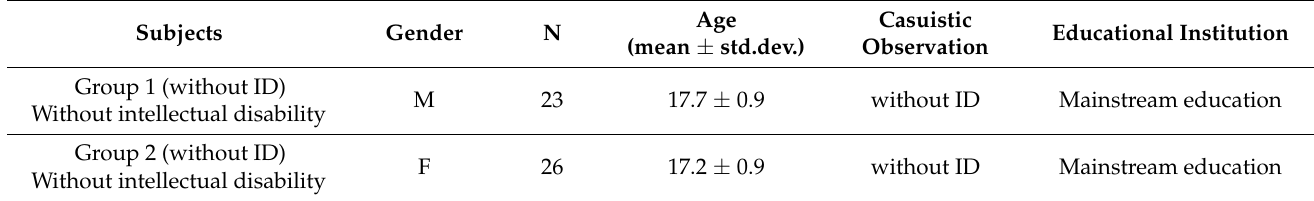
Table 1. Repartition of the subjects by age, casuistry, and educational